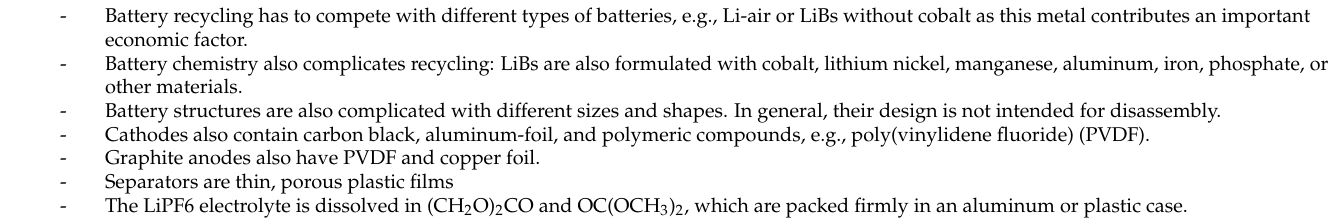
Table 8. Technical challenges for recycling lithium-ion batteries.